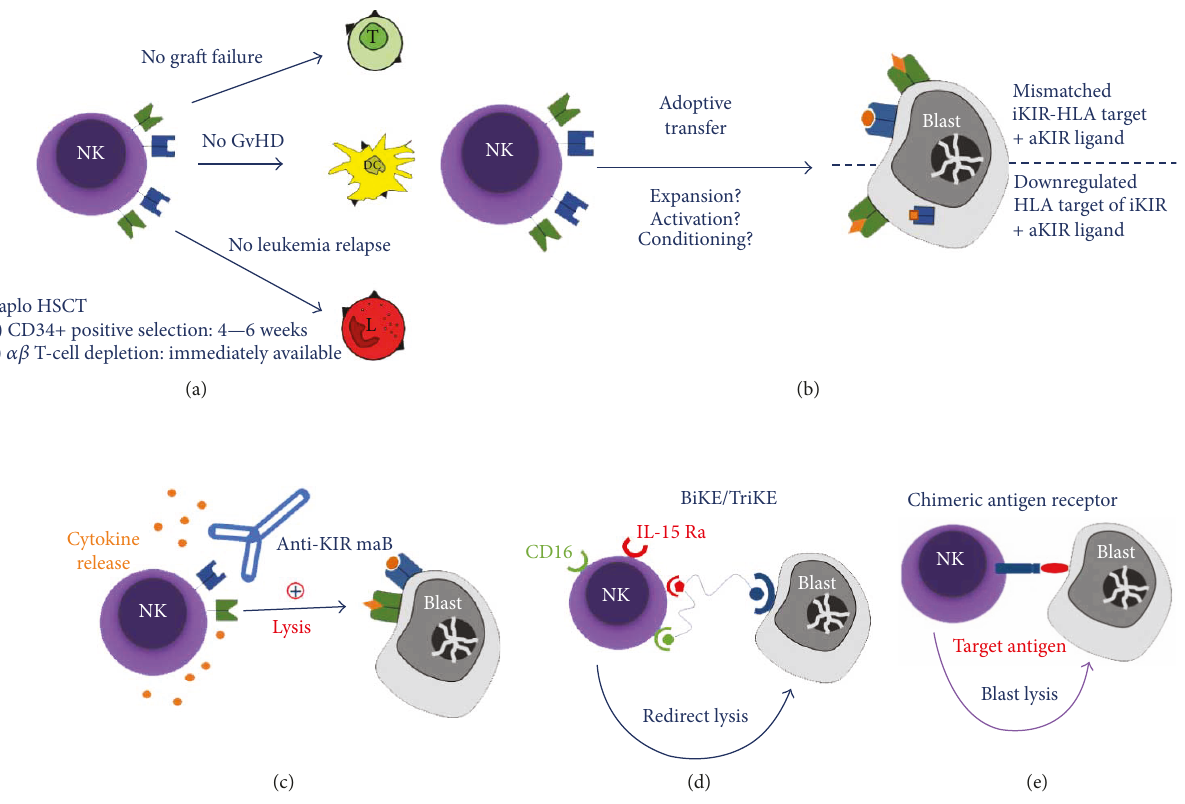
Figure 1: Mechanisms of natural killer (NK) cell-mediated antileukemic e ff ect. Natural killer cells play a signi fi cant role in immunological defense against leukemia. (a) Following haploidentical hematopoietic stem cell transplantation, donor NK cells facilitate engraftment by eliminating recipient T cells, fail to elicit graft-versus-host disease (GvHD) by eliminating recipient dendritic cells, and suppress leukemia relapse through a direct cytotoxic e ff ect on leukemic blasts, particularly in the setting of inhibitory killer immunoglobulin-like receptor (KIR) mismatch which leads to a failure of inhibitory signaling in the NK cell. (b) Adoptive transfer of NK cells leads to leukemic blast killing through either inhibitory KIR mismatch or downregulation of inhibitor KIR ligands (MHC) by the leukemic blast, as well as the provision of ligands for activating receptors present on the blast surface. Questions remain as to the best approach to NK cell expansion and activation as well as patient conditioning for adoptive transfer. Several methods to boost NK cell activation are under investigation, including (c) anti-inhibitor KIR antibody, (d) bispeci fi c and trispeci fi c killer engagers (BiKEs and TriKES) linking NK cells to target cells and providing activating signals, and (e) the generation of NK cells possessing a chimeric antigen receptor to target leukemia antigen. Green =activating KIR (on NK cells) or KIR ligand (on target cells); blue=inhibitory KIR (on NK cells) or KIR ligand (on target